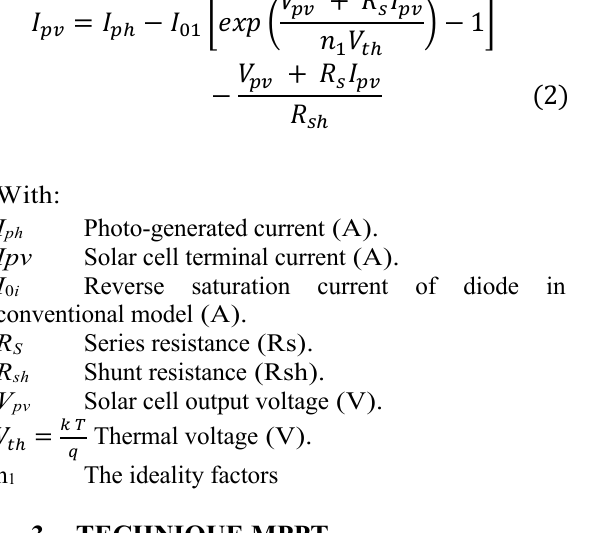
Table 1: SPECIFICATIONS of the PV module used in